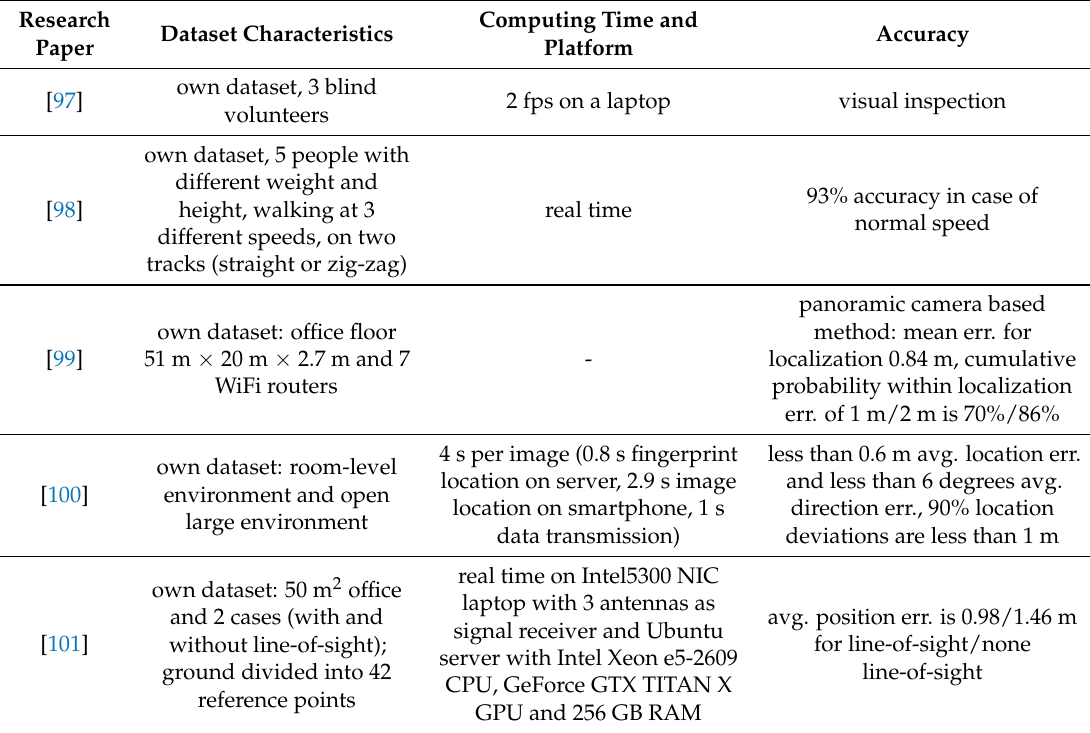
Table 12. Characteristics of indoor localization solutions with real image/feature databases, 2D cameras + other sensors, and artificial